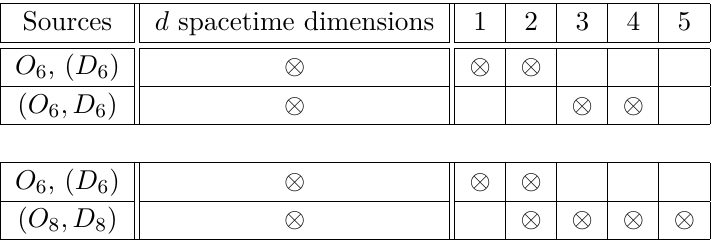
Table 2 . Supersymmetry-preserving source configurations allowing for possible de Sitter solutions in type IIA in d = 5